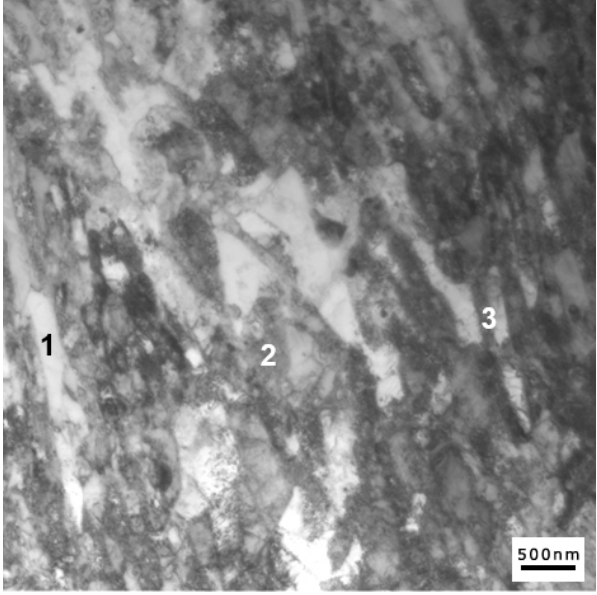
Figure 11. TEM micrograph of Heat A tempered at 650 °C. Numbers in the figure identify the regions where Energy dispersive X-ray EDX microanalysis was performed. Results for Cr, Mn, and Ni weight percentages are reported in Table 3. Table 3. Content of Cr, Mn, and Ni measured by EDX microanalysis from the different regions marked in Figure 11.